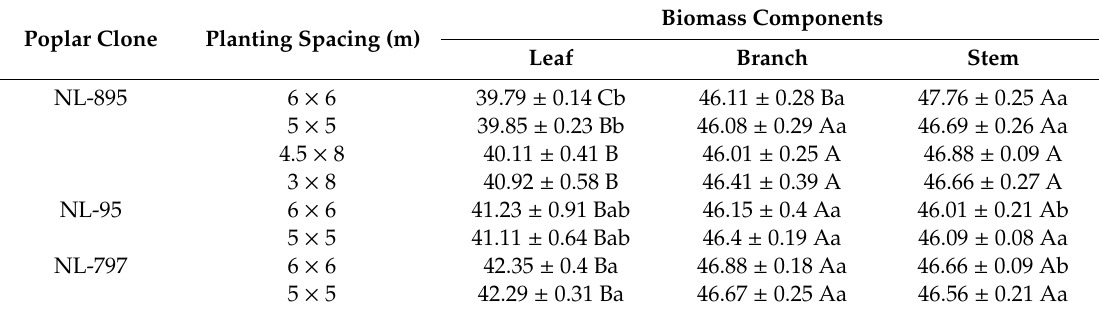
Table 3. The average carbon concentrations of di ff erent biomass components from the poplar plantations with various treatments (%).